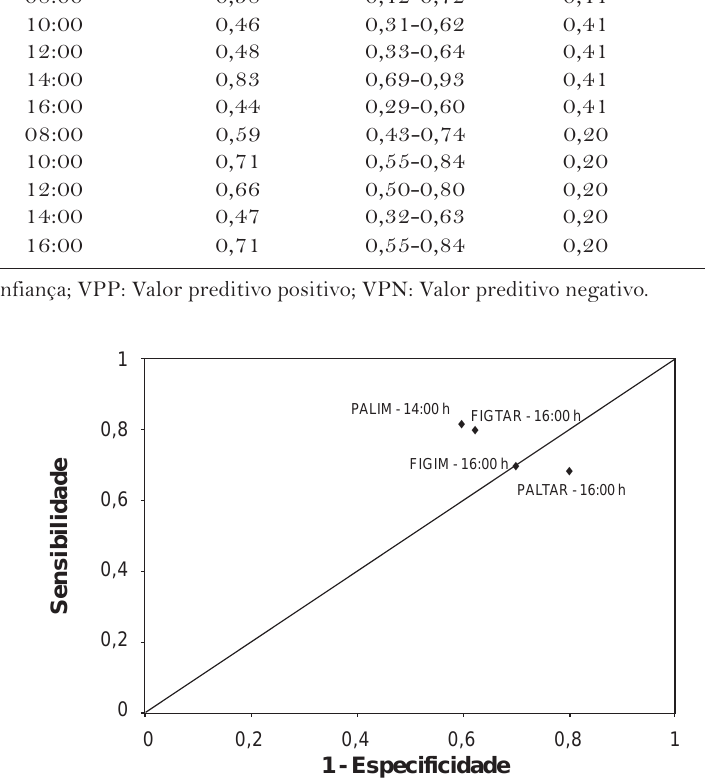
Figura 2. Coordenadas da Curva ROC para os testes utilizados, considerando os horários de maior poder